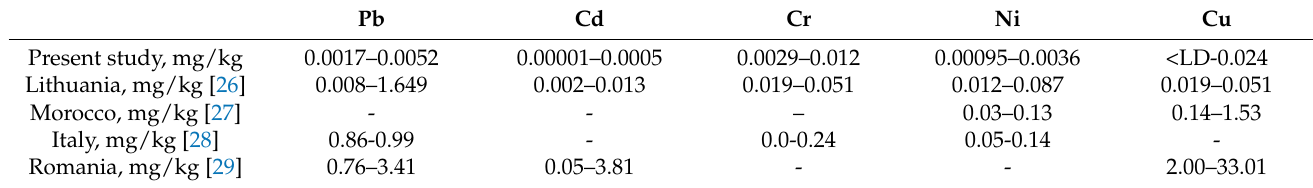
Table 6. Metal concentrations in honey samples from different